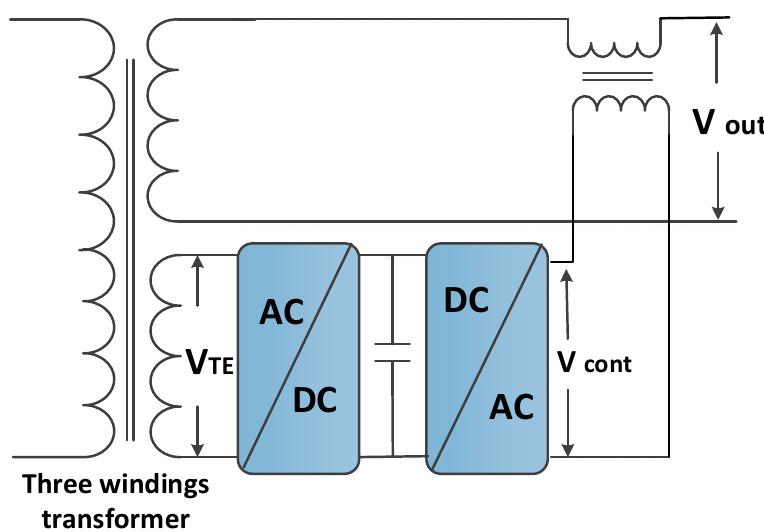
Figure 1. The typical configuration of the HT.